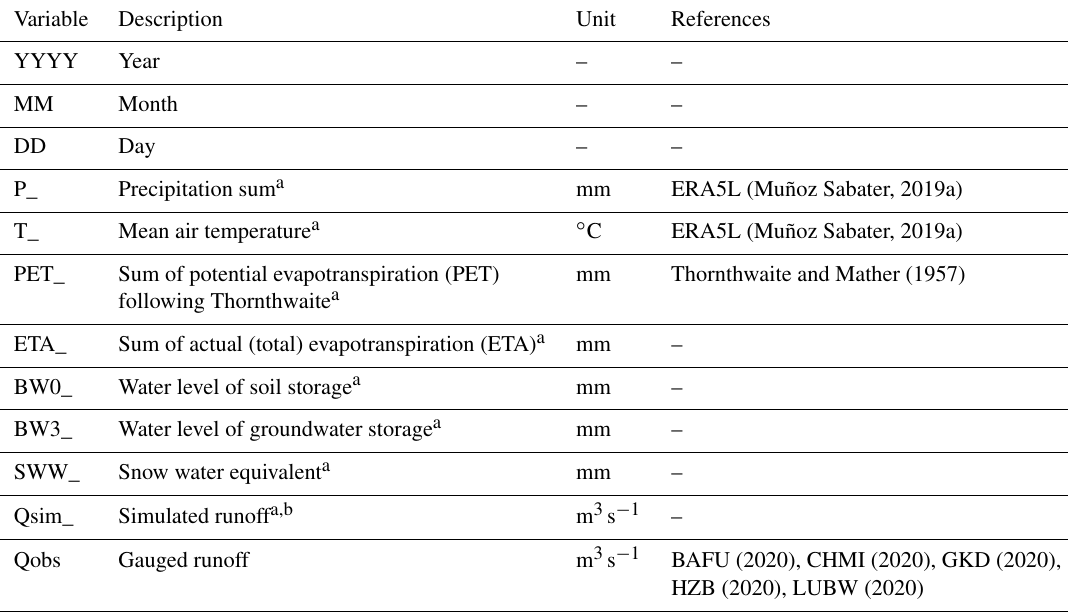
Table C2. Provided input/output time series from the hydrological model COSERO.